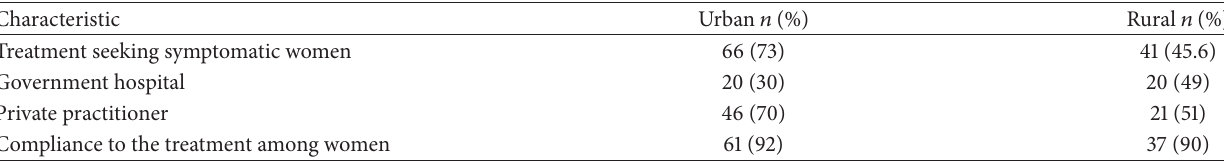
Table 4: Treatment seeking behaviour of the respondents.